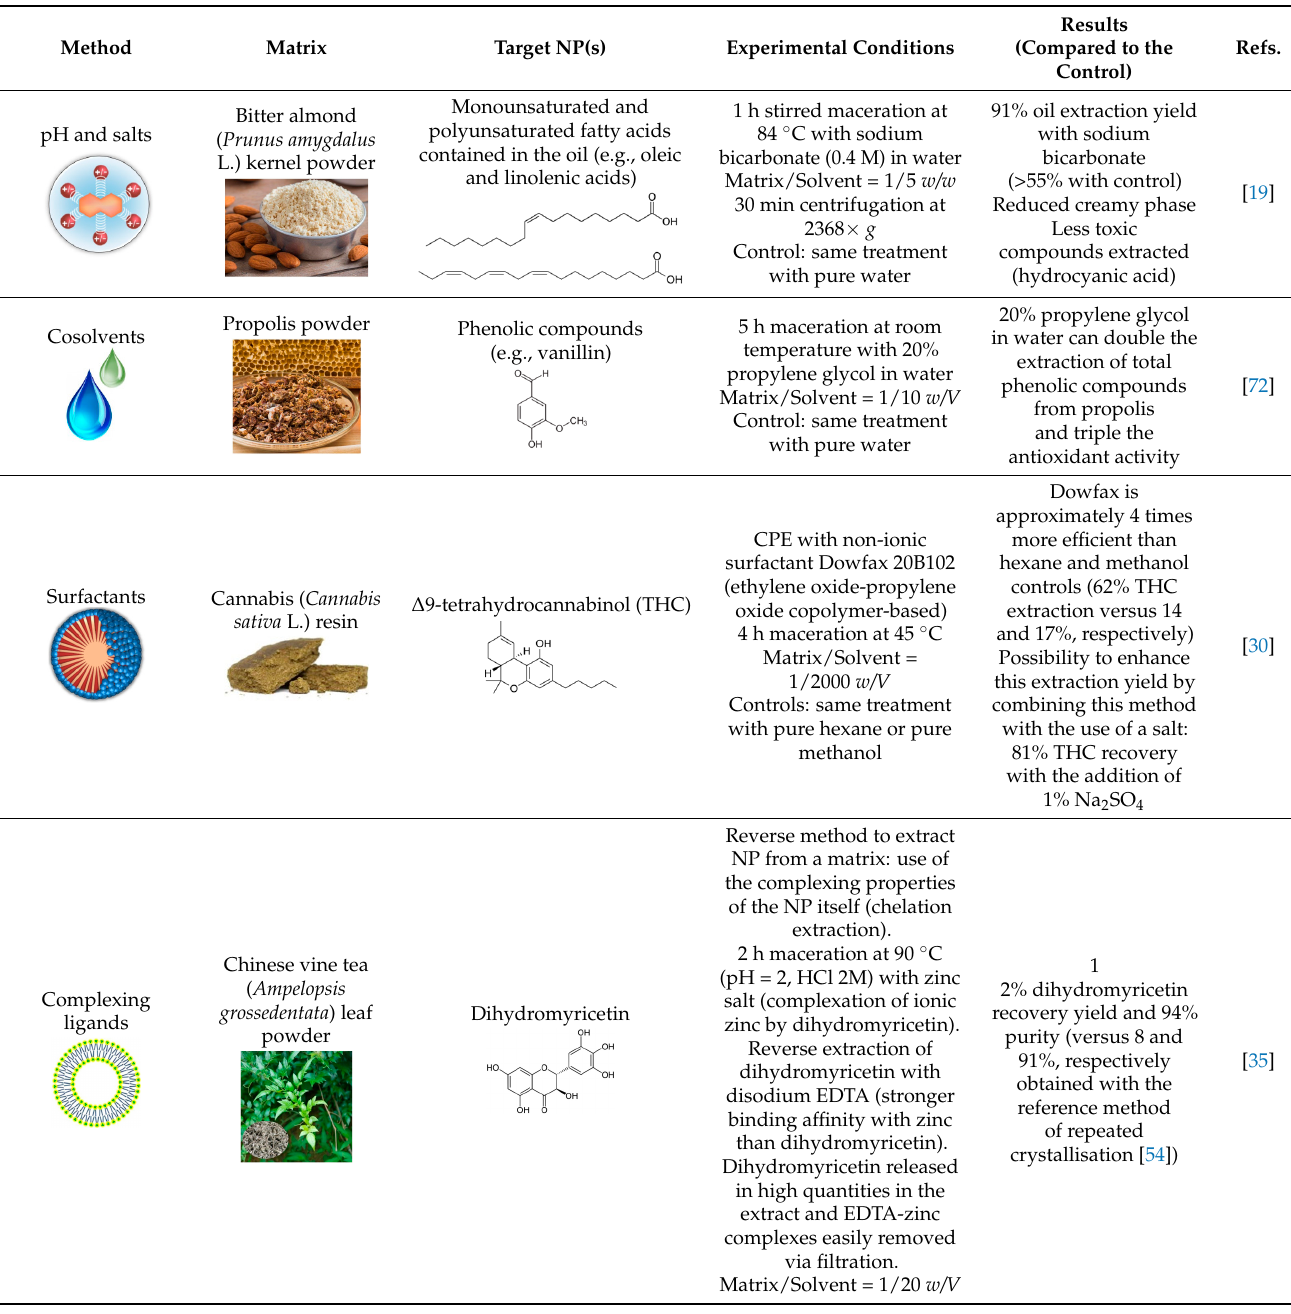
Table 1. Presentation of a successful case of green extraction for each method.